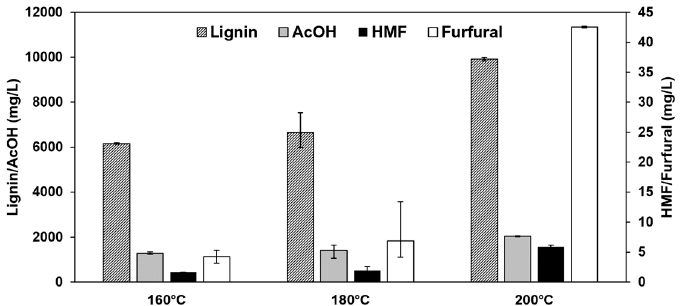
Figure 8. Average concentrations and spans of the components lignin, acetic acid, HMF, and furfural in the undiluted organosolv extracts at different pretreatment temperatures.